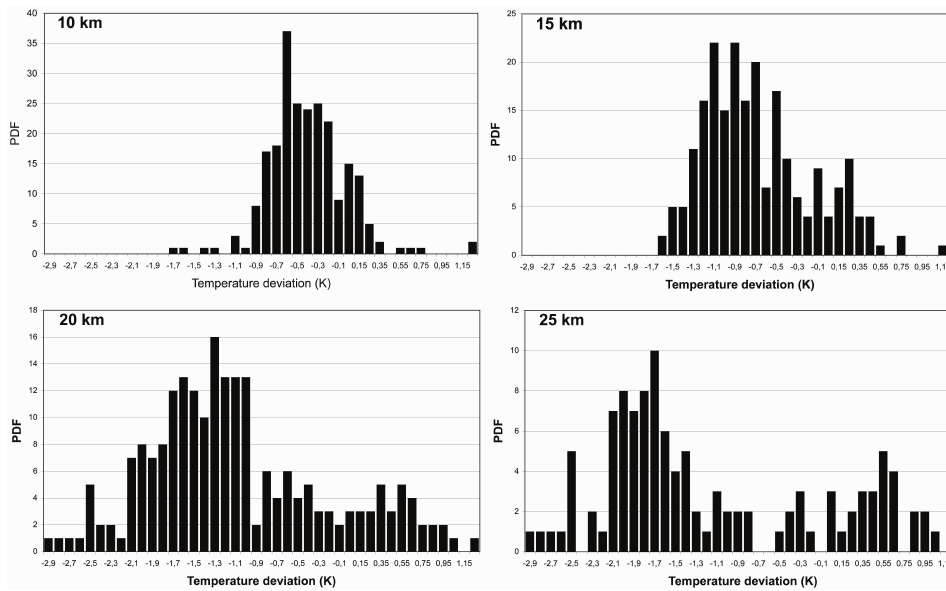
Fig. 3. Anomaly distributions between O3-PTU and Meteo-PTU measured temperatures every 5km from 10 to